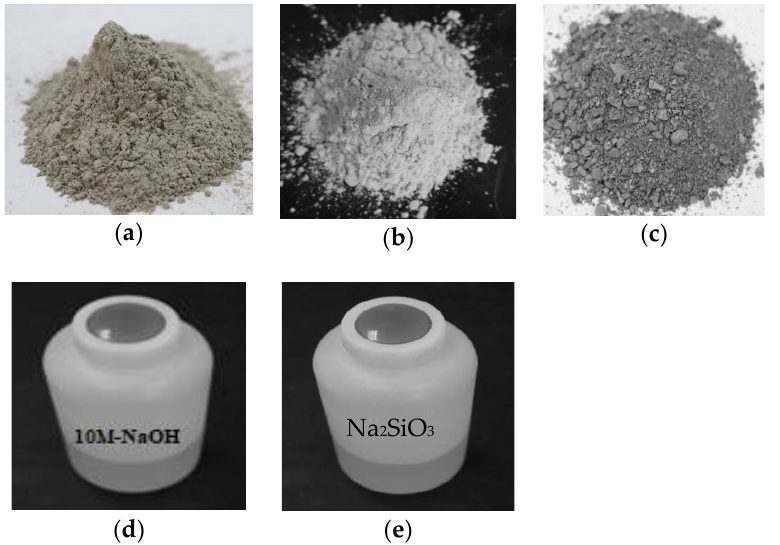
Figure 1. The main constituents of the geopolymer mixture: are ( a ) fly ash (FA); ( b ) GGBS; ( c ) river sand; ( d ) 10 M-NaOH; ( e ) Na 2 SiO 3 . Table 1. Specification of liquid sodium silicate (Na 2 SiO 3 ).